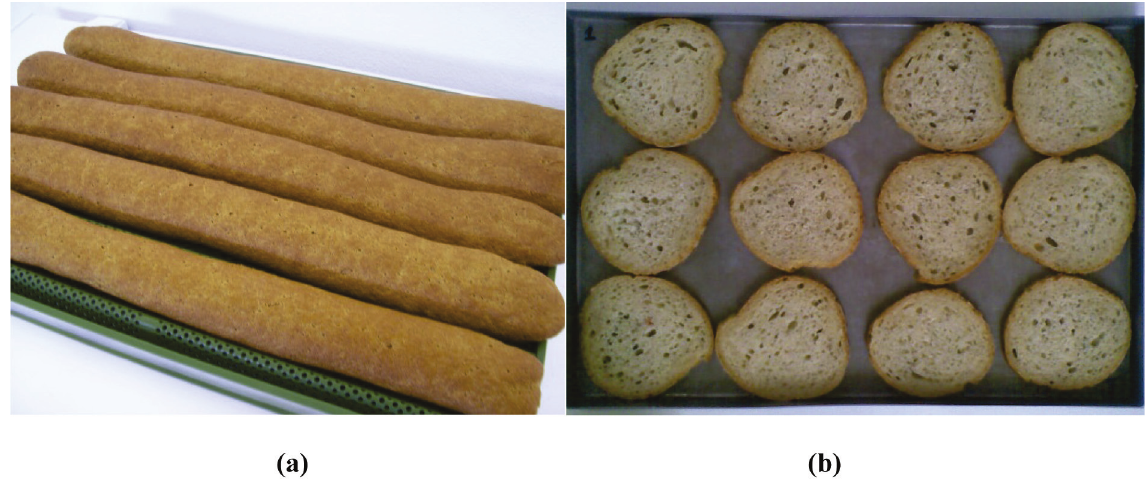
Figure 1 - Images of baked baguette bread ( a ), and sliced baguette ( b